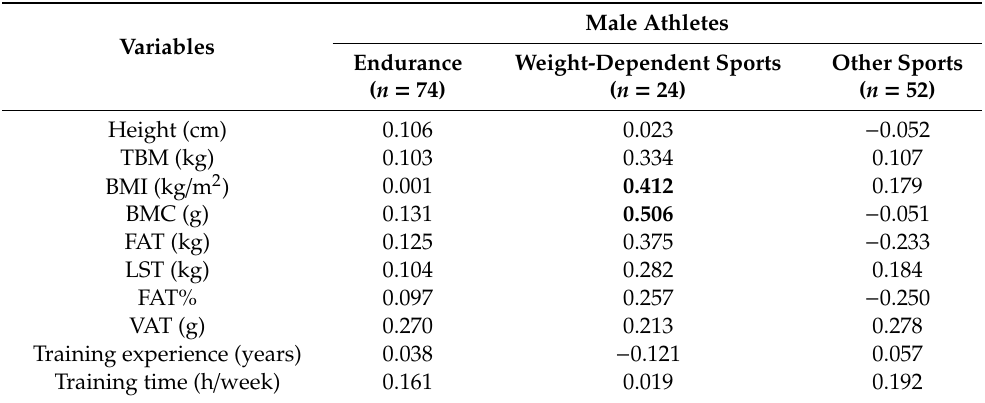
Table 6. Relationship between ORTO-15 score and anthropometric measurements, body composition, training loads and training experience in male athletes including type of e ff